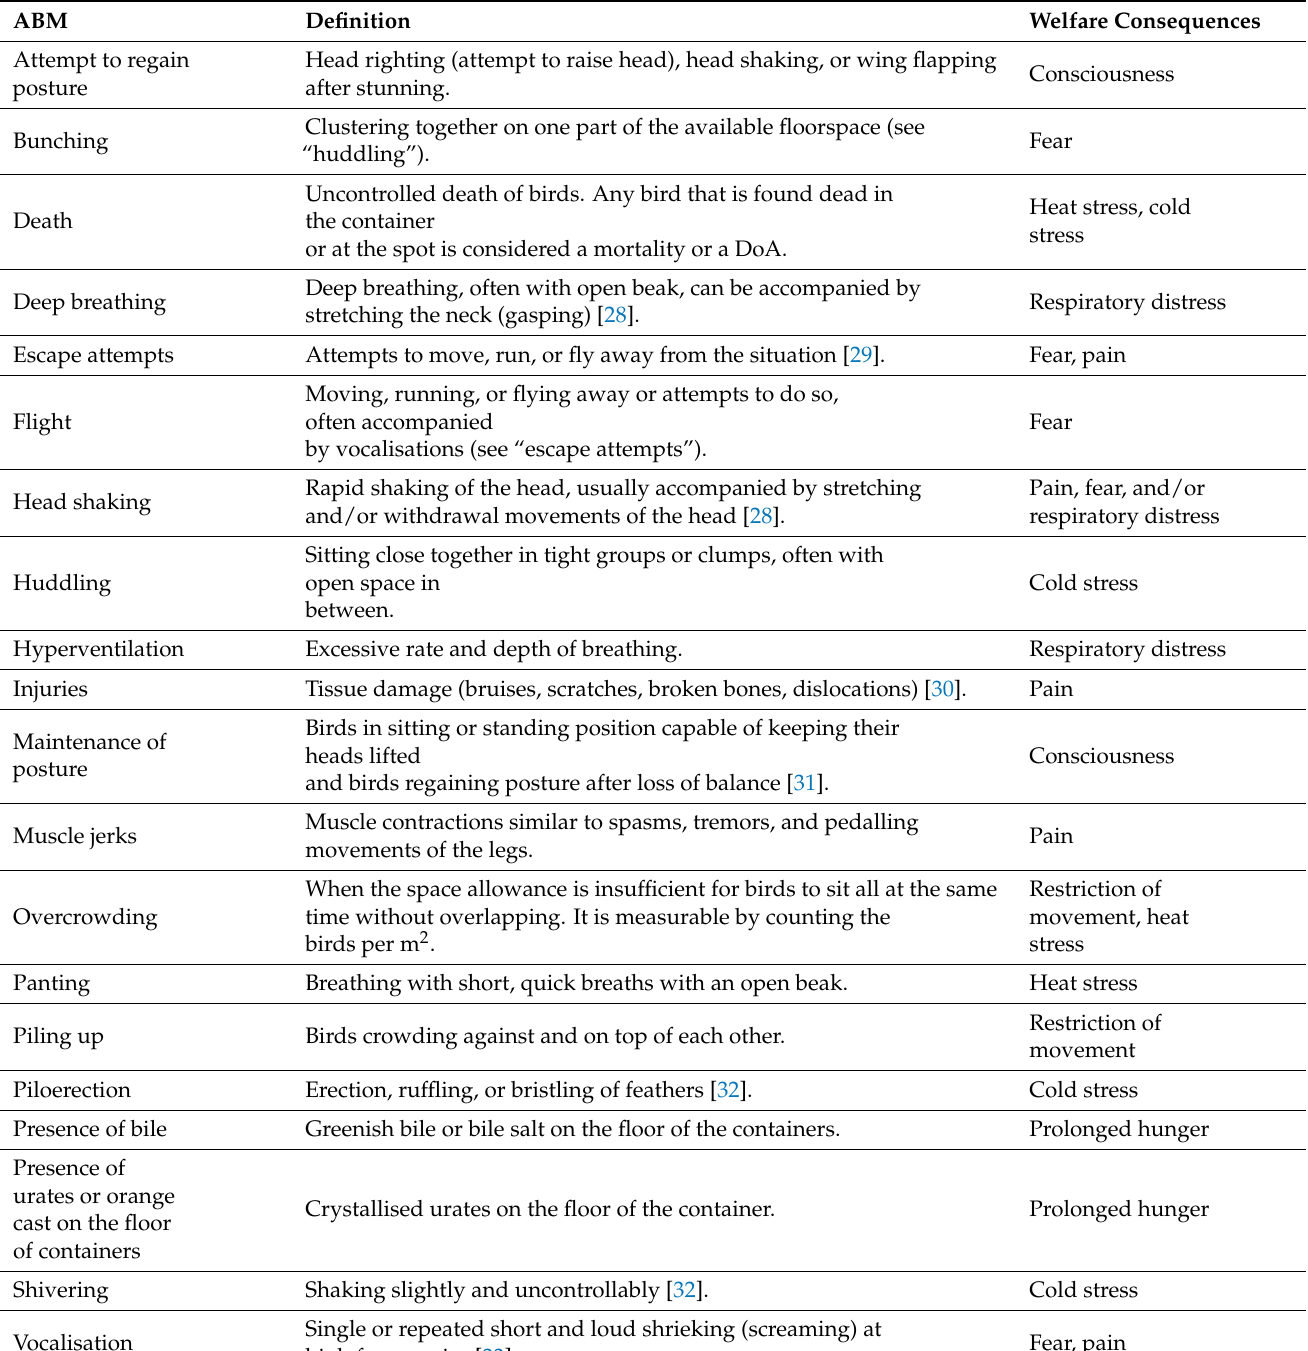
Table 1. List of ABMs, their definitions, and welfare consequences (adapted from EFSA